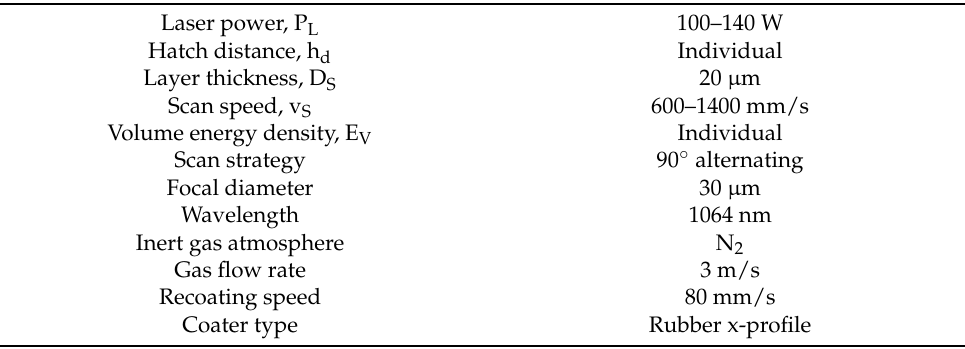
Table 3. PBF-LB/M nominal process parameters and environmental properties applied to